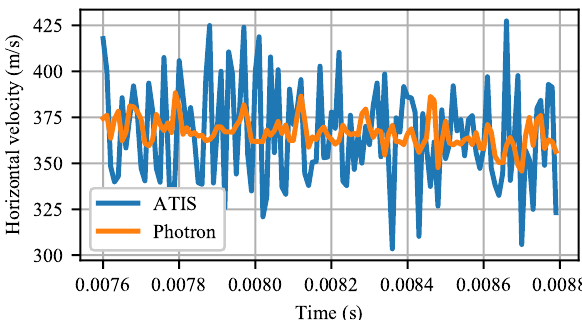
Figure 16. Horizontal projectile velocity estimated by the Photron and ATIS cameras along a 440 mm long trajectory segment at a constant 100 kHz sampling rate.